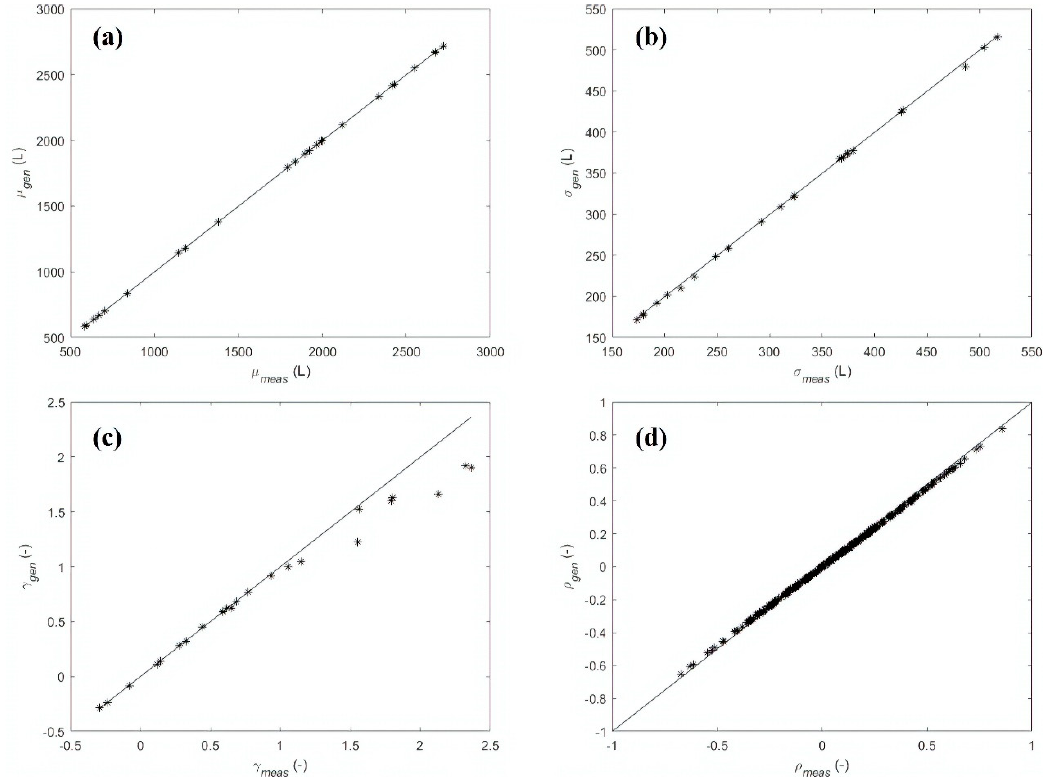
Figure 5. Case study 1 (Application 2)—Comparison between measured and generated aggregated hourly demands: ( a ) mean values µ , ( b ) standard deviation values σ , ( c ) skewness γ , ( d ) rank cross-correlations ρ .